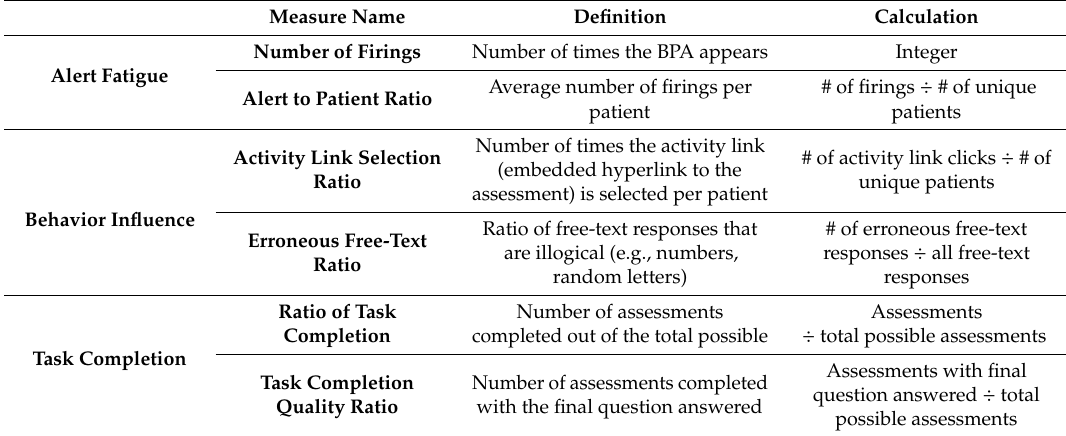
Table 1. Measures Used to Evaluate the E ff ectiveness of the Storyboard Format on the Learning Screen